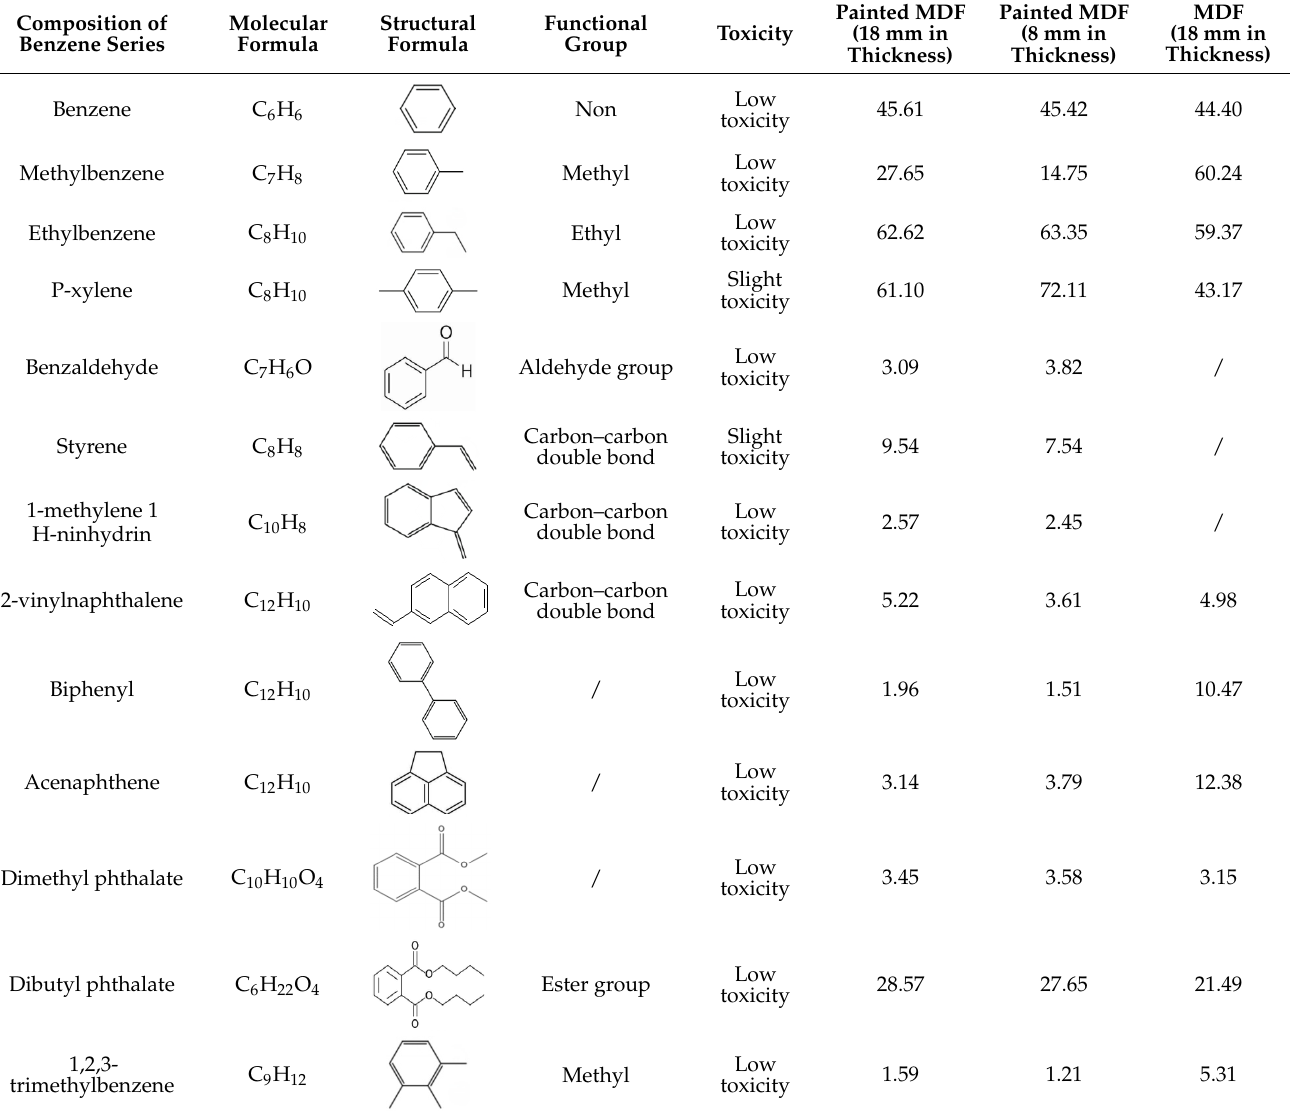
Table 1. Composition of Benzene Series and total concentration released by three kinds of MDF ( µ g · m − 3 ).